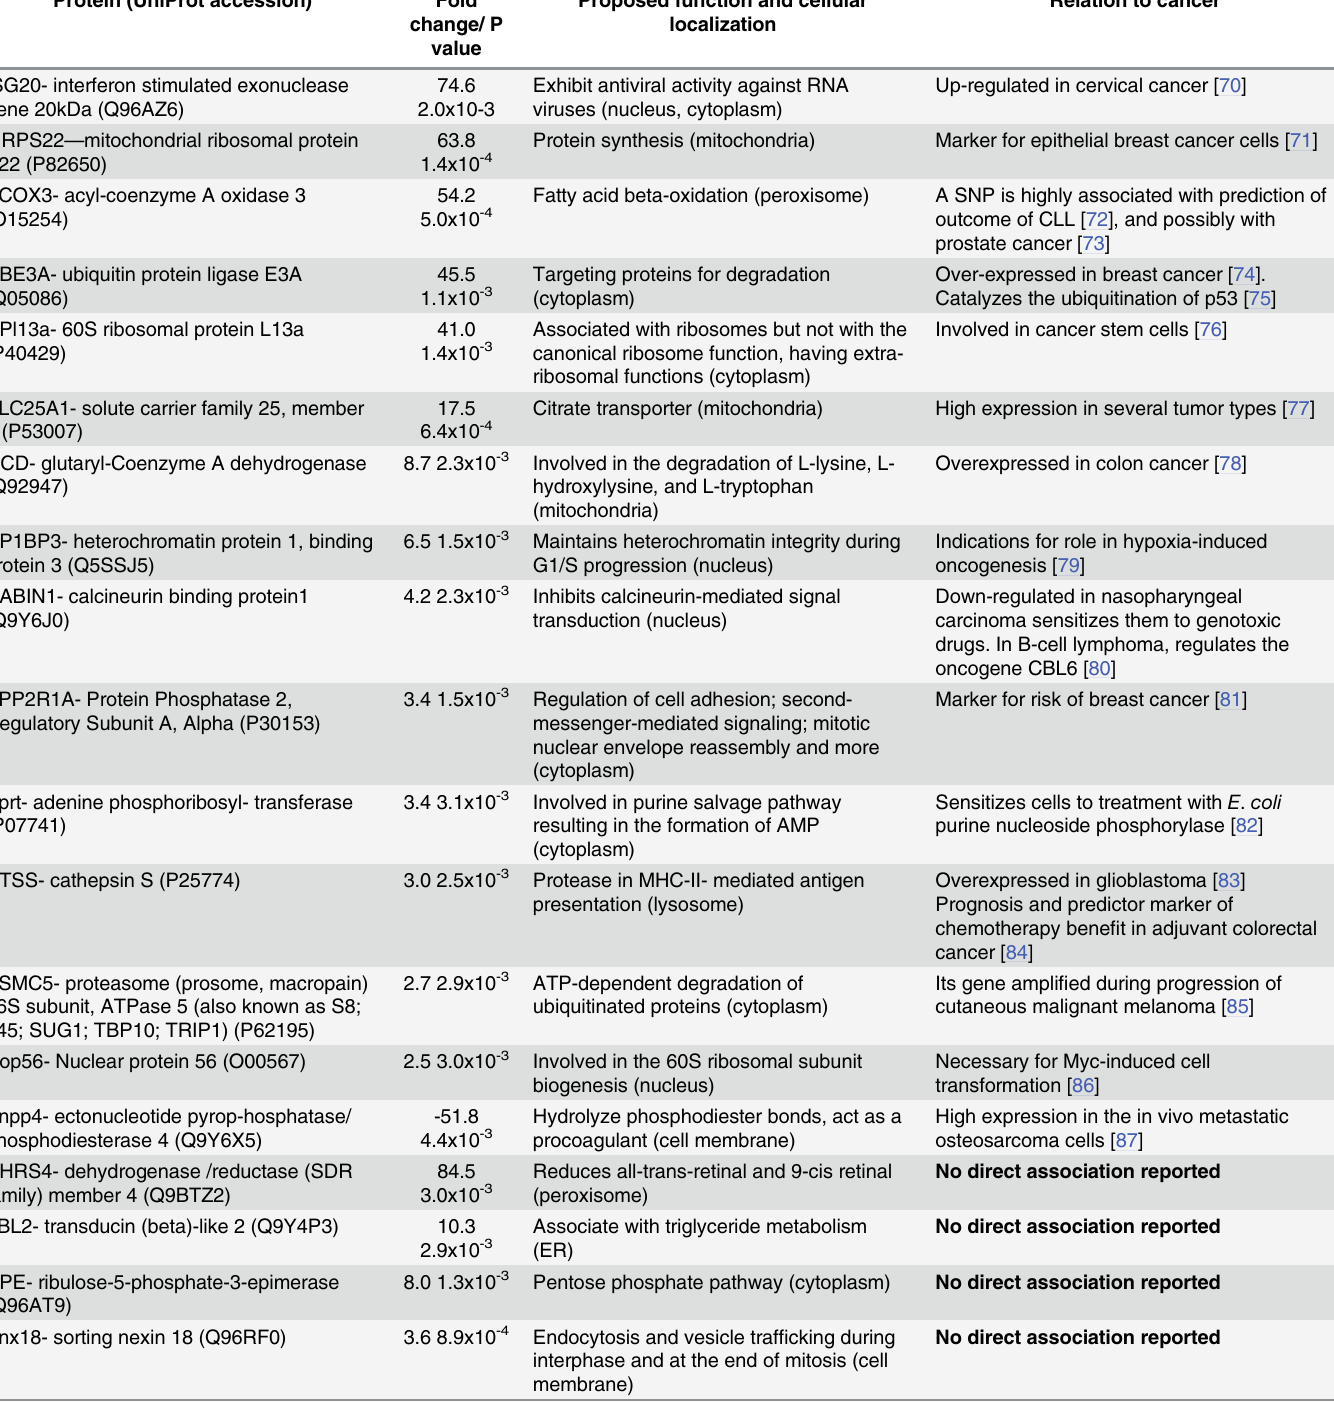
Table 2. List of selected proteins differentially expressed between CLL patients in a stable disease state and those transferred to anti-cancer treat- ments, identified by LC-HR-MS/MS. Protein (UniProt